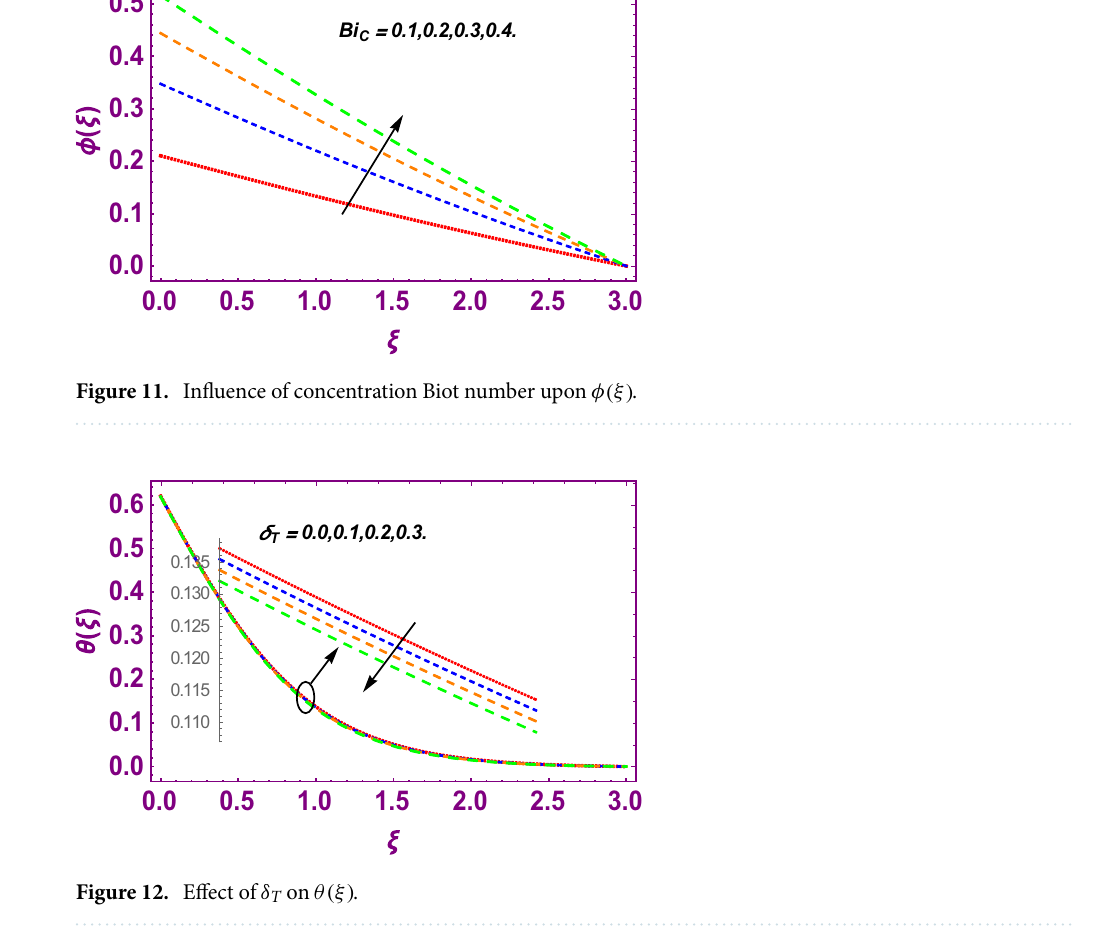
depicted in Fig. 16. Intensifying values of K r results the retardation of mass diffusivity that weakens the thickness of concentration boundary layer thickness. Hence, higher values of K r causes a decline in concentration profile. Using variations in different parameters the results of current investigation have been compared with established results in the literature. In Tables 2 and 3, a comparison is carried out for results of Iqbal et al. 50 , Khan et al. 51 and Makinde and Aziz 52 for different values of stretching ratio parameter, while keeping other parameters zero. A fine agreement of current results with those established in literature has been found. In Table 4, it has noticed that the values of C sx and C sy have been retarded with augmentation in the values of solid volume fraction, modified Hartmann number, stretching ratio and slip factors. The numerical